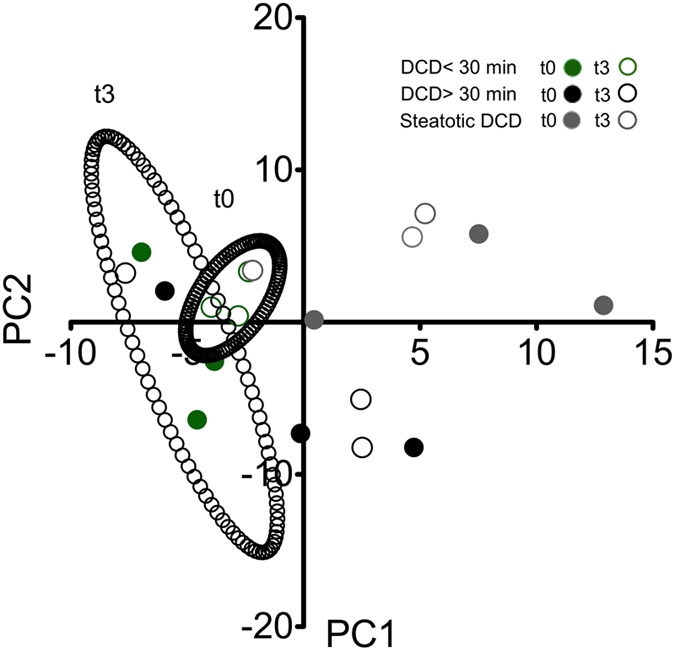
Multivariate analysis of pre- and postperfusion metabolomic profile.Principal component analysis of DCD <30 min (green), DCD >30 min (black), and steatotic DCD livers (grey) pre- (open circles) and postperfusion (filled circles), providing a 2-dimensional (PC1/PC2) representation of the untargeted metabolomic profile. Clustering of control livers is seen, both pre- and postperfusion. All but one of the steatotic DCD and DCD >30 min livers show separation from the DCD <30 min livers, lying outside the 95% confidence interval of the pre- and postperfusion controls (black ellipses).